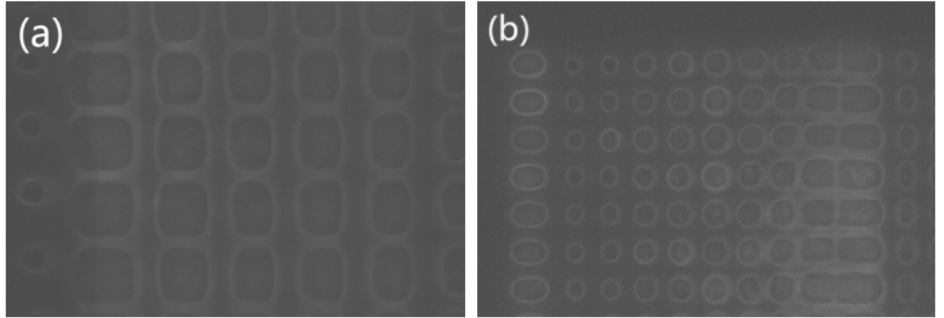
Figure 3. The scanning electron microscopic image (SEM) of samples: ( a ) the SEM image at 82,490× magnification; ( b ) the SEM image at 46,400× magnification.